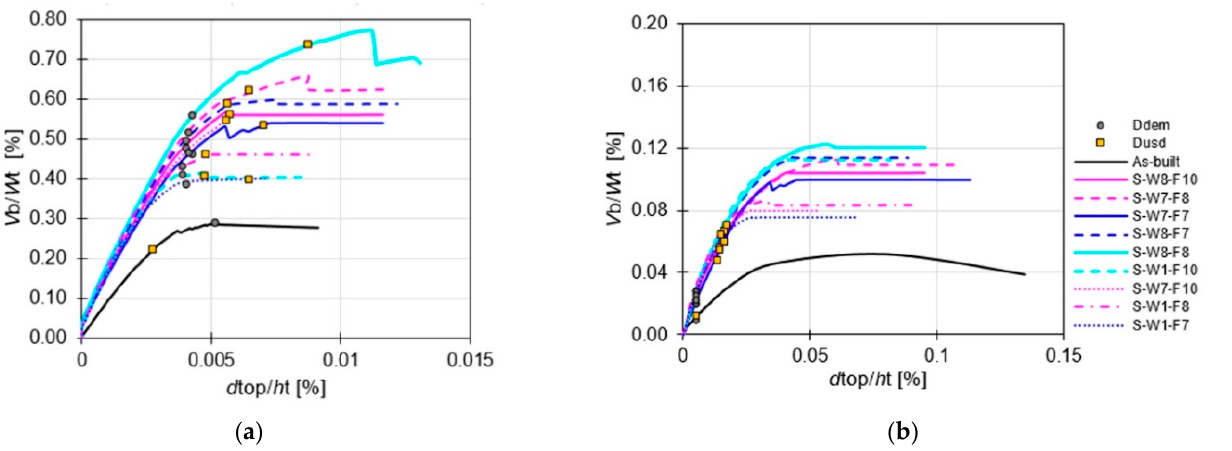
Figure 17. Normalised SDOF-NLS curves considering the RP3 solutions in the X- ( a ) and Y-directions ( b ).